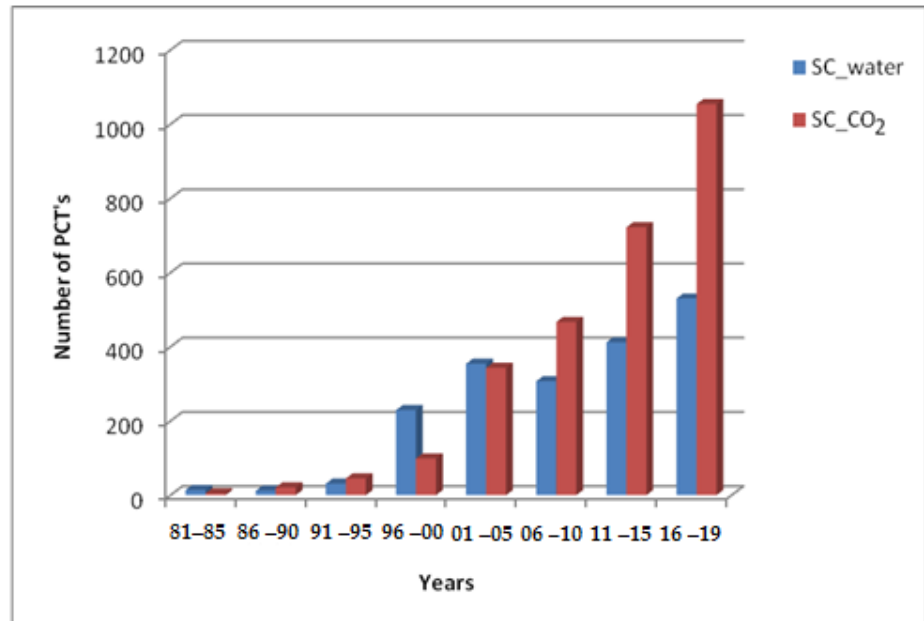
Figure 1. Number of PCT with Sc-water and SC-CO 2 for the period from 1981 to 2019 (from PA- TENTSCOPE-World Intellectual Property Organization (WIPO) database of international PCT ap- plications).